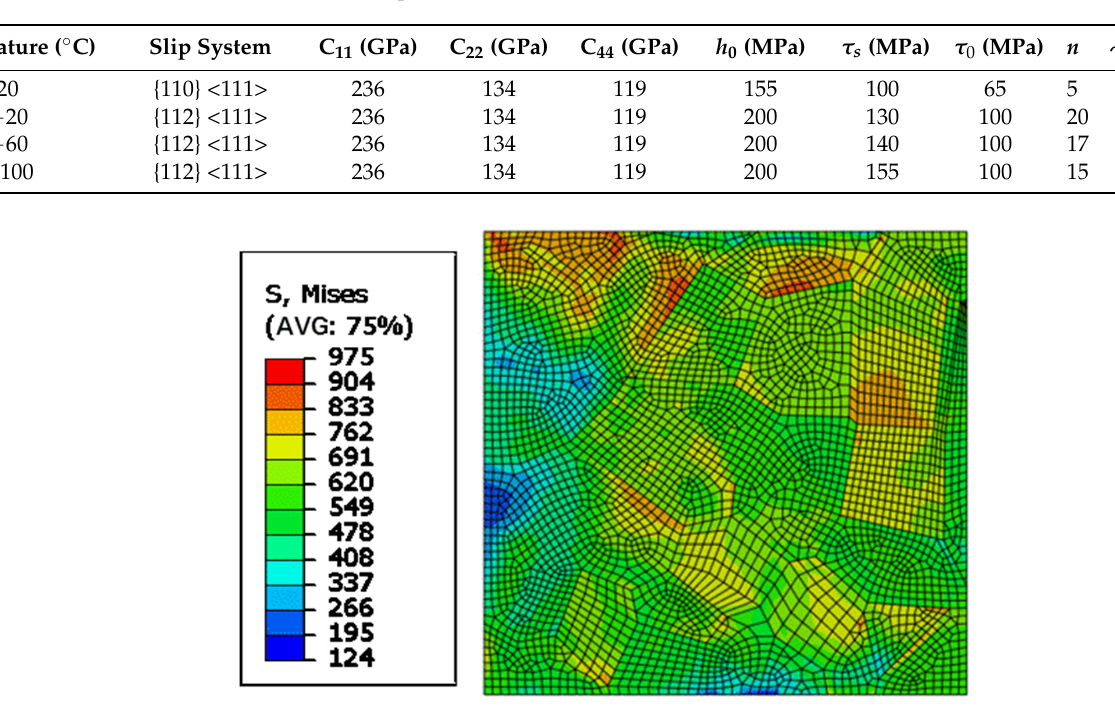
Figure 6. Comparison between tensile test and simulation results. Table 3. Material parameters used in the simulation model.